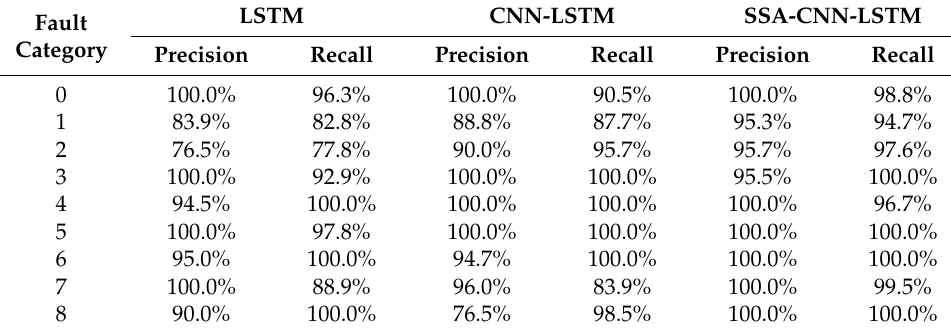
Figure 10. Confusion matrix of the testing dataset. ( a ) Confusion matrix of testing dataset for the LSTM neural network, ( b ) Confusion matrix of testing dataset for the CNN-LSTM model, and ( c ) Confusion matrix of testing dataset for the SSA-CNN-LSTM model. Table 8. Accuracy and recall rates of the